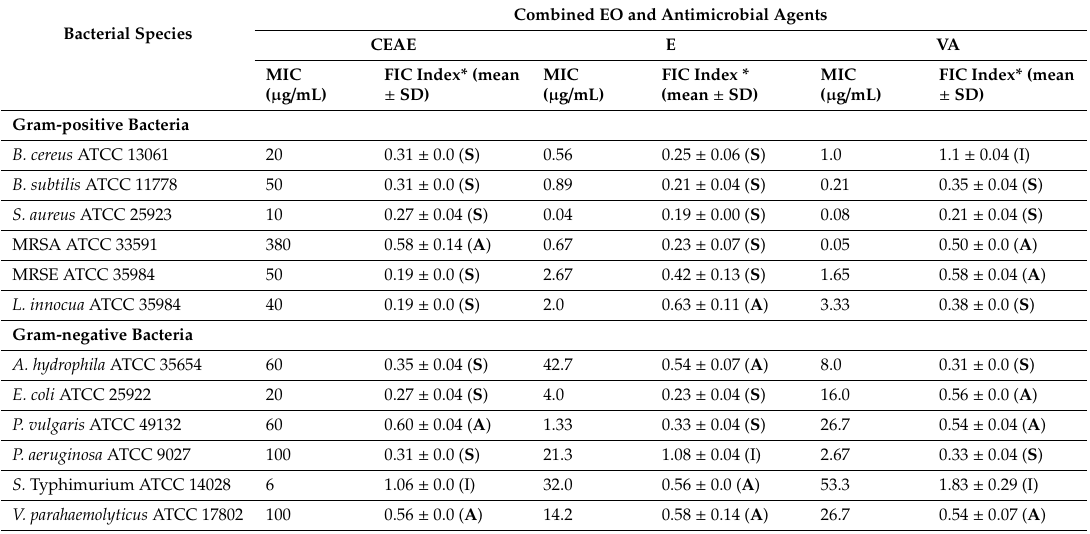
Table 4. Interaction between L. cubeba fruit EO and CEAE, antibiotics expressed as the fractional inhibitory concentration (FIC) index. Combined EO and Antimicrobial Agents Bacterial Species CEAE